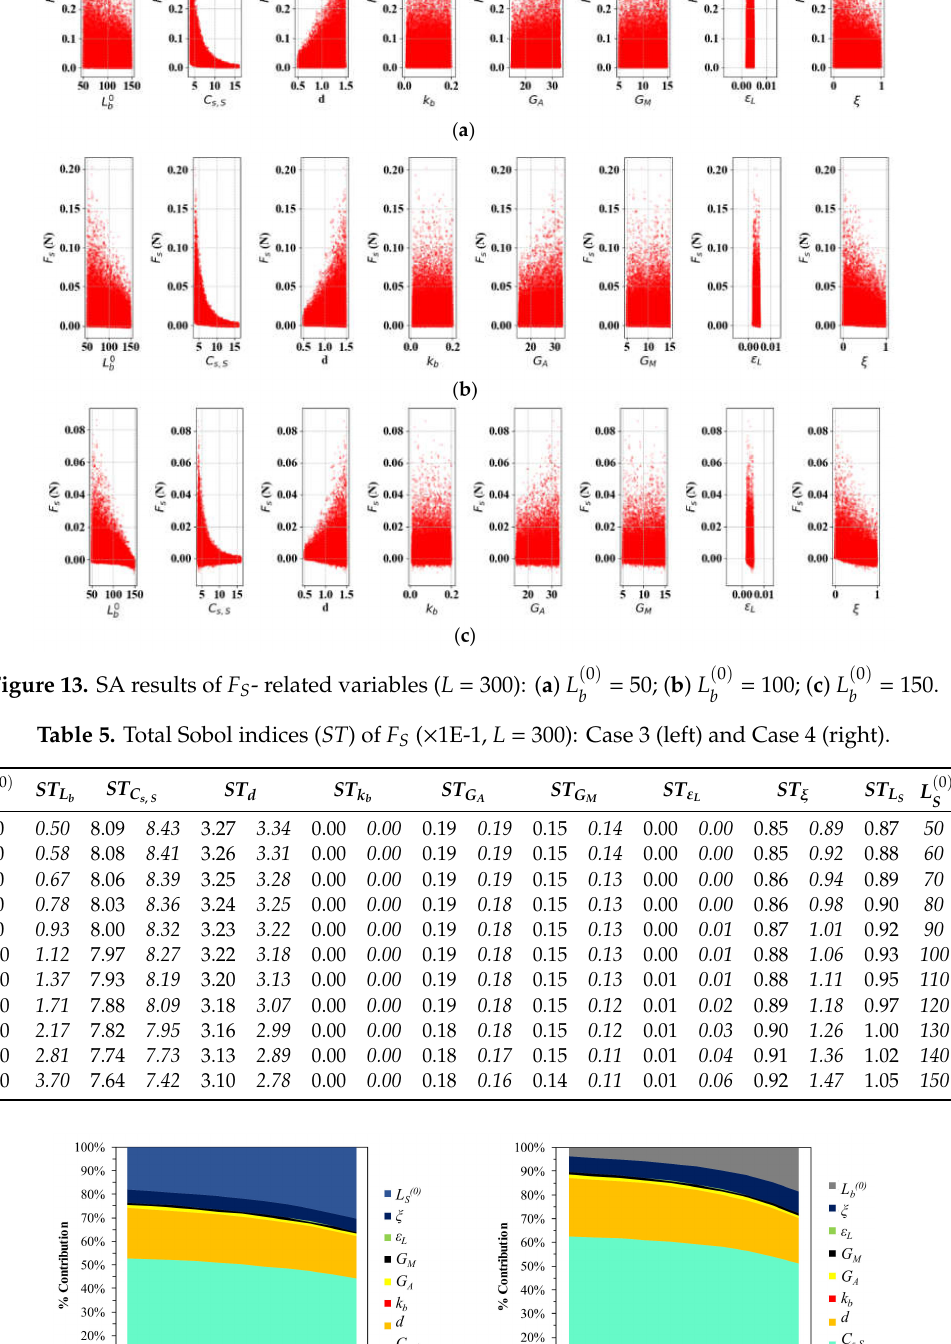
Figure 14. Parametric percentage contribution to the SMA force ( F S ): ( a ) Variation in bias spring length; ( b ) Variation in initial SMA spring